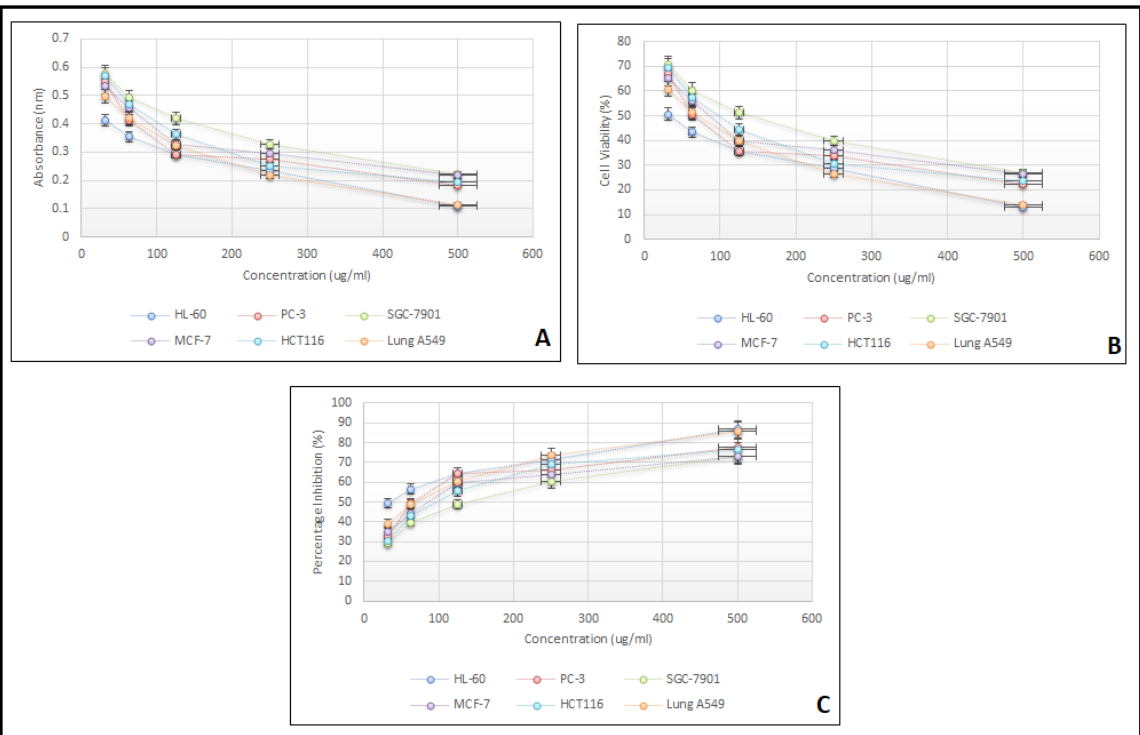
Figure 6. Structure of PH-HM-10 (Pegaharmine E). Table 3. NMR ( 1 H and 13 C) chemical shifts value of PH ‐ HM ‐ 10.